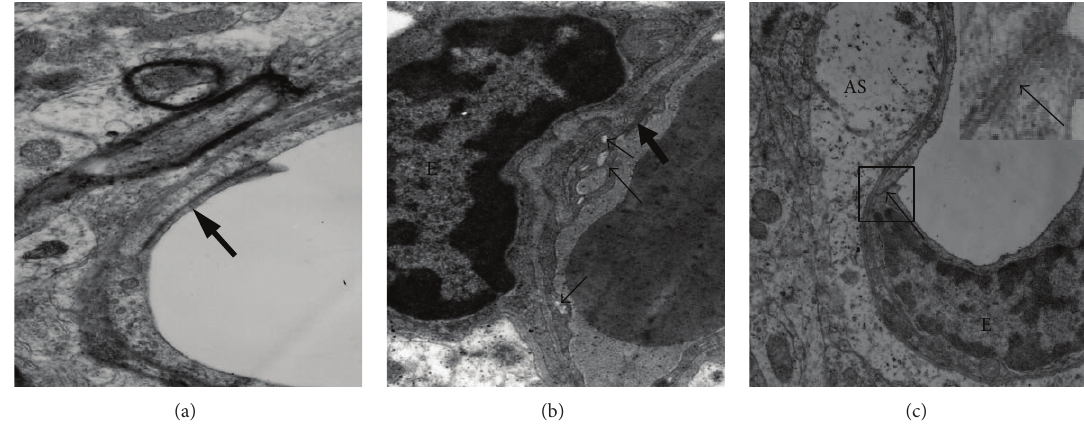
Figure 2: Transmission electron microscopy of mouse brains from D-galactosamine and liposaccharide-induced ALF. (a) Control ( × 12000 magnification). TJs (arrow) were intact. (b) ALF mouse ( × 15000 magnification). EC was shrunken, vesicles and vacuoles (small arrows) were present, and TJs (large arrow) were complete. (c) Another ALF mouse ( × 12000 magnification). The feet of perivascular astroglial cells (AS) were swollen. TJs (arrow) were disrupted. The rectangular area was magnified in the upper